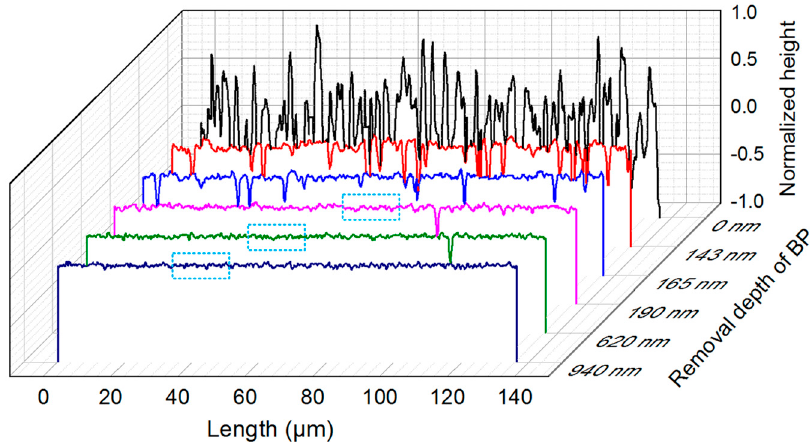
Figure 8. Cross-section profiles of substrate F under different removal depth of BP.